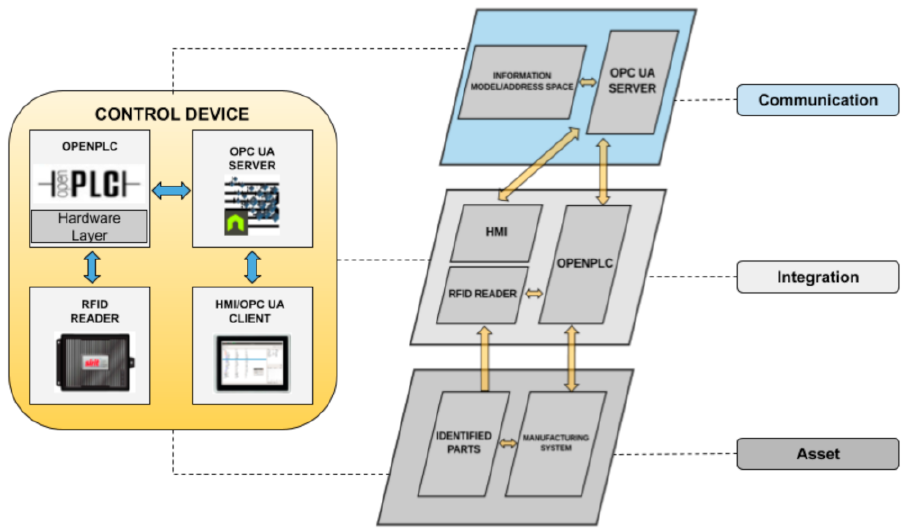
Figure 3. Architecture of the control device for